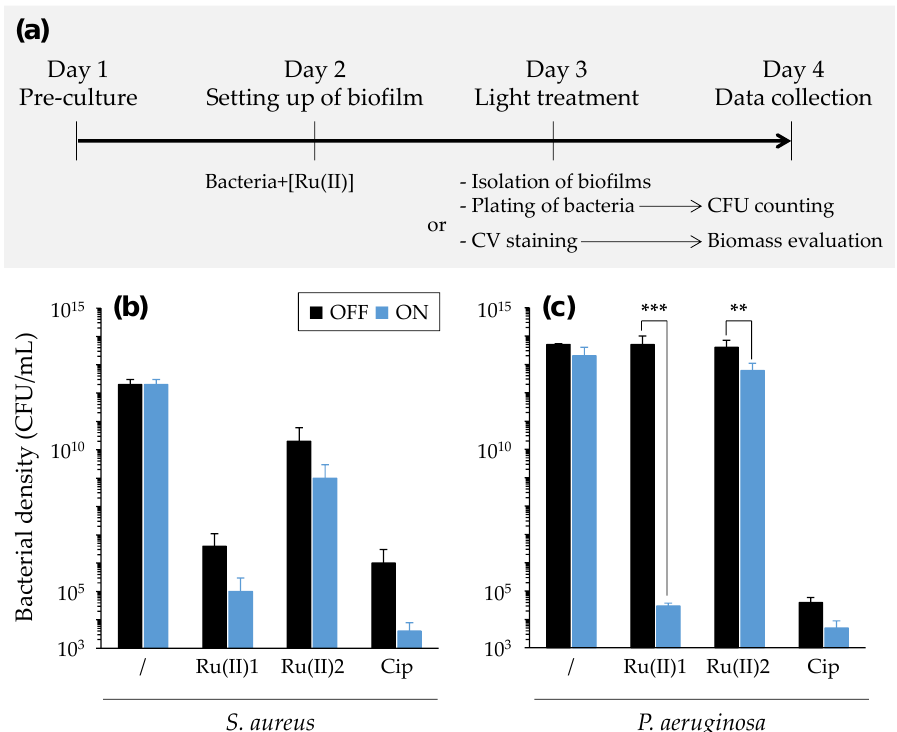
Figure 9. PDT effect of [Ru(II)] towards bacteria in biofilms (“pre-delivery antibiofilm assay”). The workflow of the experimentation is presented ( a ) with the results obtained when assaying S. aureus RN4220 ( b ) and P. aeruginosa PA19660 ( c ). Mean SD with n = 3 and N = 3. ***, p - value ≤ 0.001; **, p - value ≤ 0.01. “Cip”: ciprofloxacin.